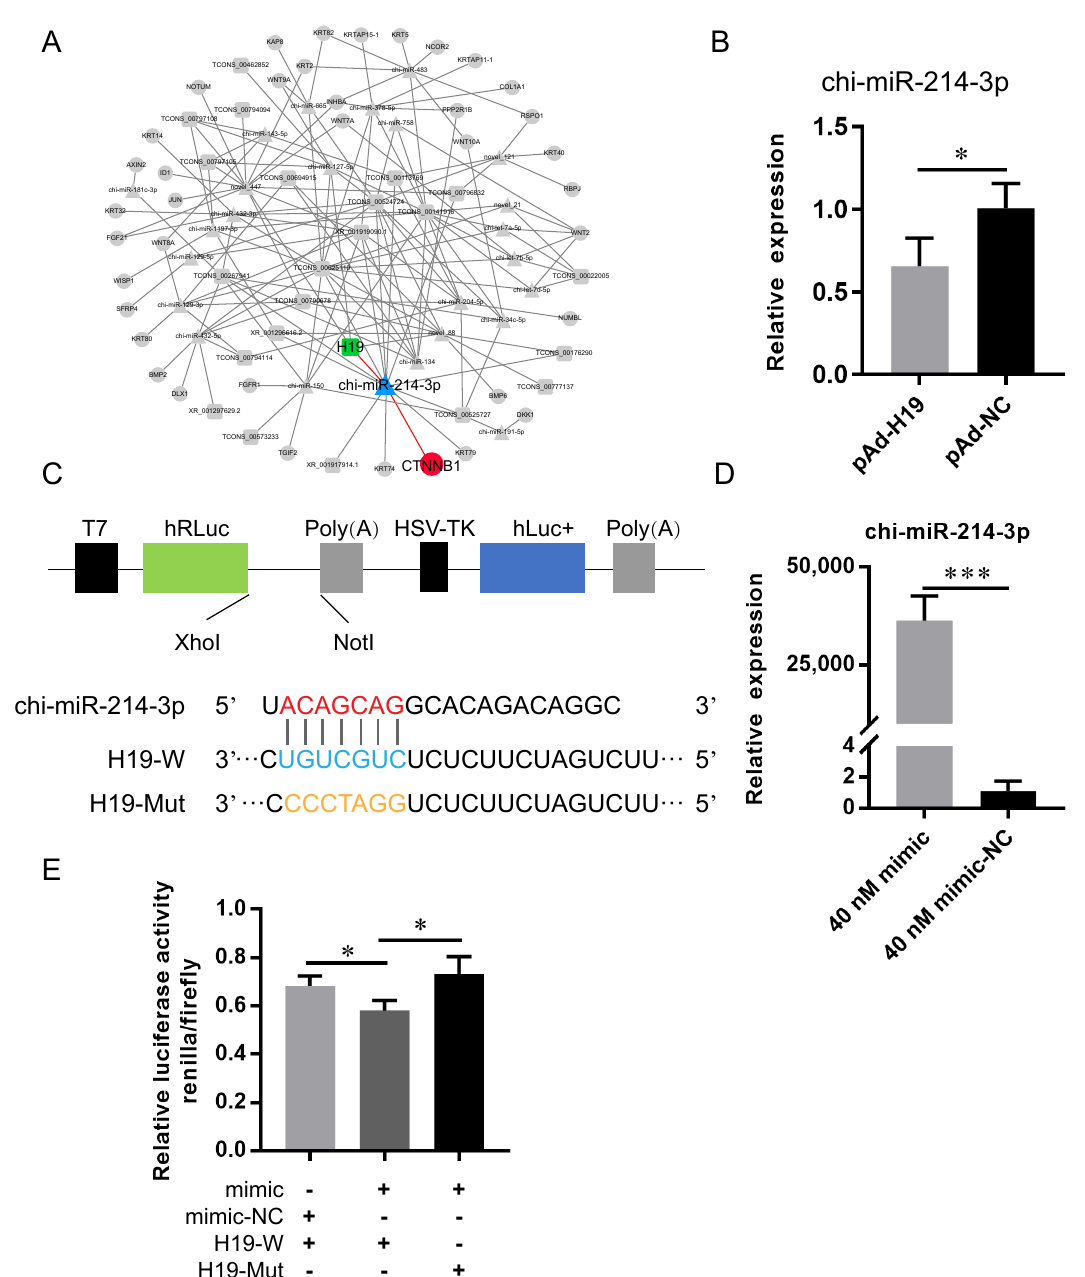
Figure 3. H19 targeted chi-miR-214-3p. ( A ) The ceRNA network showed H19-chi-miR-214-3p- β - catenin. H19 was shown in green, chi-miR-214-3p was shown in blue, and β -catenin (CTNNB1) was shown in red. ( B ) RT-qPCR of chi-miR-214-3p expression after transfection with adenoviruses pAd-H19 and pAd-NC. ( C ) Schematic of the double-luciferase assay vector. Red nucleotide sequences represented the seed sequences of chi-miR-214-3p. The binding site of chi-miR-214-3p in H19 was shown in blue. Orange nucleotide sequences represented the mutation in the seed-binding site of H19. ( D ) RT-qPCR detected the effect of chi-miR-214-3p mimic in HEK293T cells. ( E ) Analysis of the luciferase reporter assay after transfecting with chi-miR-214-3p mimic-NC + H19-W, chi-miR-214-3p mimic + H19-W, or chi-miR-214-3p mimic + H19-Mut. The data were presented as mean ± SEM for 3 biological replicates, * p < 0.05. *** p <